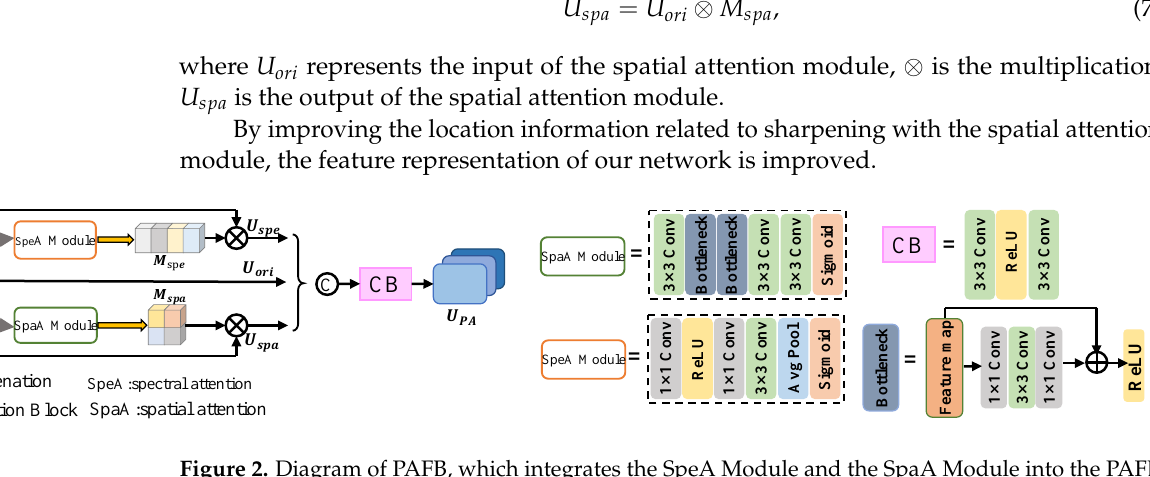
Figure 2. Diagram of PAFB, which integrates the SpeA Module and the SpaA Module into the PAFB. ⊗ and ⊕ denote the elementwise multiplication and the elementwise sum operation,